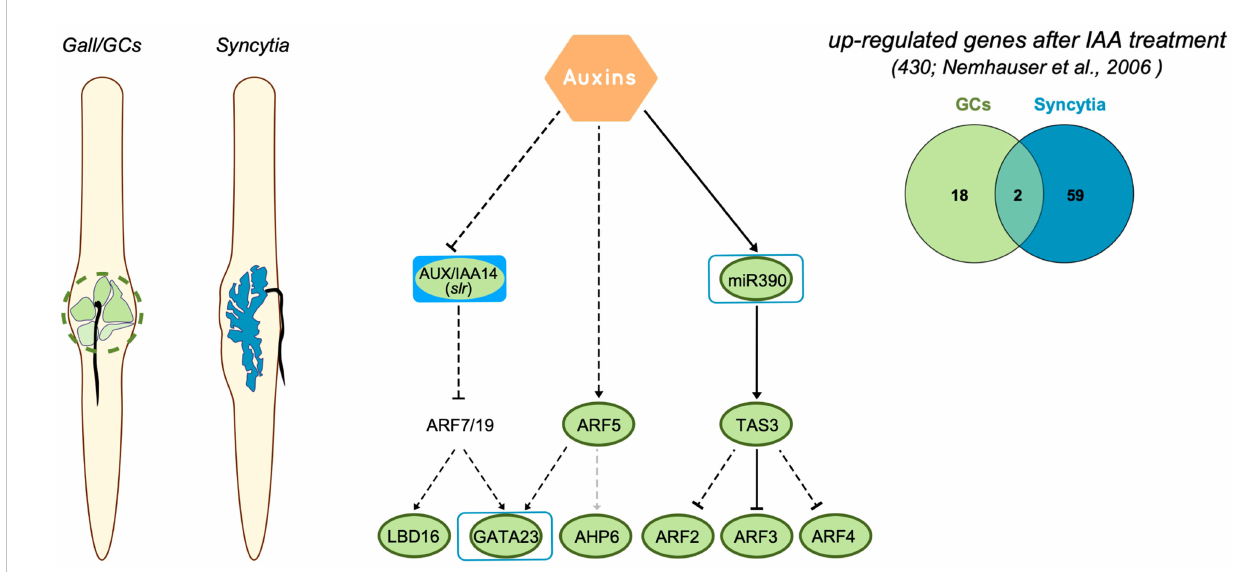
FIGURE 6 Regulation of auxin-responsive genes crucial for LR formation in CN and RKN infection sites of Arabidopsis. Right panel, metanalysis of genes induced after IAA treatment in Arabidopsis (Nemhauser et al., 2006) that are also upregulated in giant cells (GCs) formed by M. javanica and microaspirated syncytia. The number of common genes between GCs versus syncytia is quite low. Left panel, representation of roots infected with root-knot nematodes and cyst nematodes, in green the GCs, in blue the syncytia. Central panel, diagram representing a pathway modi fi ed from Dastidar et al. (2012) and based on Besnard et al. (2014) with main genes regulated by auxins in LR formation and during galls and syncytia development. Dashed black lines indicate that regulation is con fi rmed during LR formation, but not yet in the root-nematode interaction, dashed grey lines indicate not yet con fi rmed for LR. The expression of most of the genes in galls was obtained from (Cabrera et al., 2014b; Olmo et al., 2020 and this paper). Those forms with solid green or blue inside indicate that the corresponding loss of function line for the gene showed a resistant phenotype after root-knot nematode or cyst nematode infection, respectively. Green lines indicate induction in RKN infection sites, blue lines indicate induction in CN infection